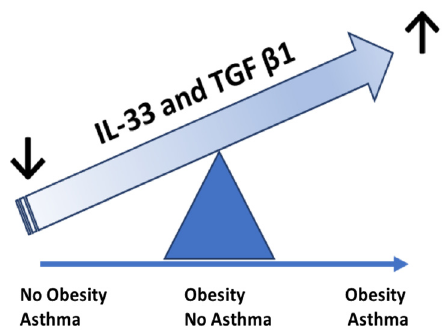
Figure 3. Hypothesis on the role of IL-33 and TGF β 1 in the transition from non-asthmatic obese phenotype to obese asthmatic phenotype. Based on the IL-33 and TGF β 1 levels, the child with obesity and no asthma is placed between the subject with normal weight and asthma and the subject with obesity and clinical asthma. With the increase of IL-33 and TGF β 1, the balance progressively moves toward the asthma–obesity phenotype.